Question: Which kind of chart has been used to present this data?
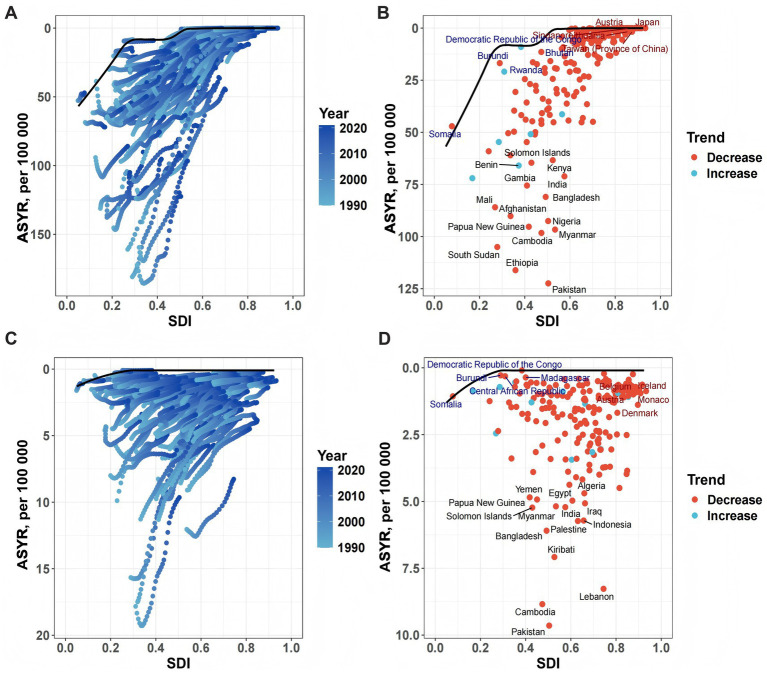
Answer: line